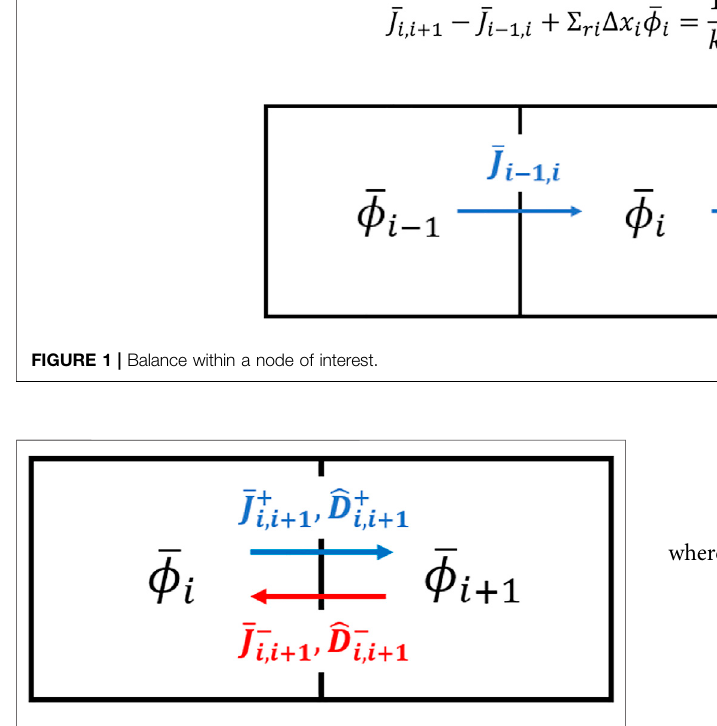
FIGURE 2 | Visualization of pCMFD correction